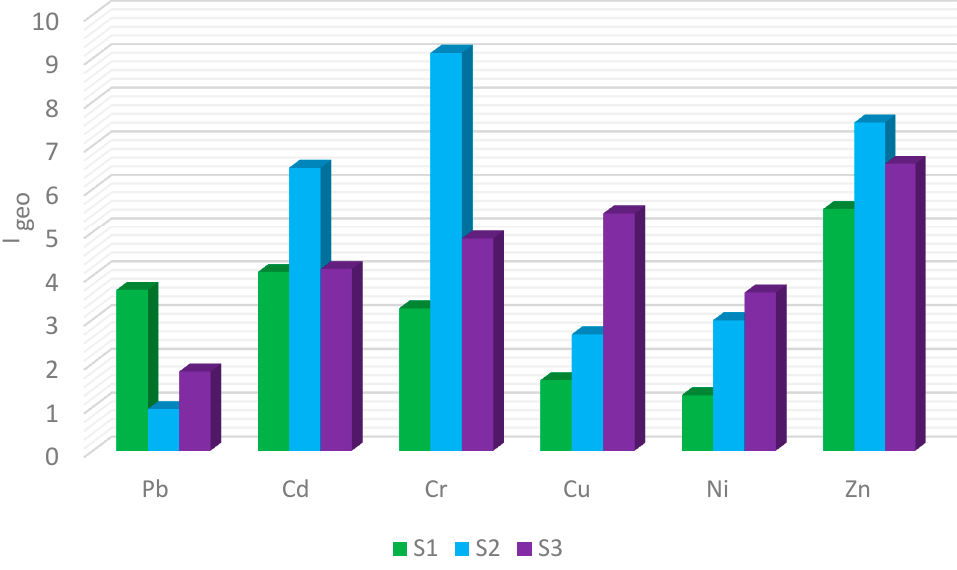
Figure 2. The geoaccumulation index ( I geo ) of HMs in SS.